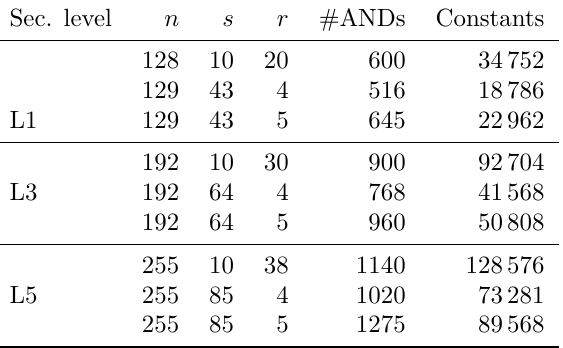
Table 4: Parameters for LowMC. Parameter n is the key and block size, s is the number of S-boxes per round, and r is the number of rounds. The baseline LowMC parameters are given in the first row of each security level, and the new alternative parameter sets follow. All parameters were chosen with data complexity d = 1. The last column shows the size in bytes of the constants required to implement each LowMC